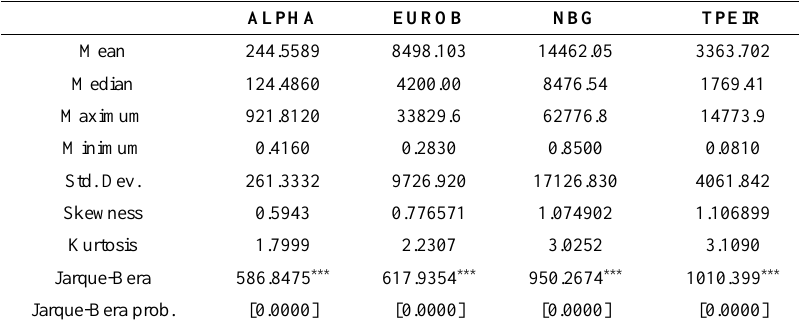
Table 1. Basic statistics of closing